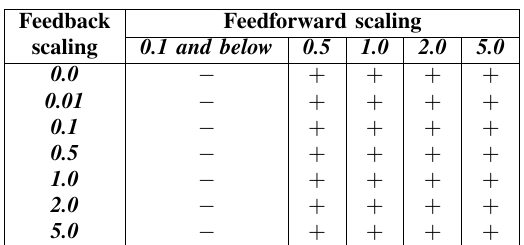
S IMULATION EXPERIMENTS Feedback Feedforward scaling